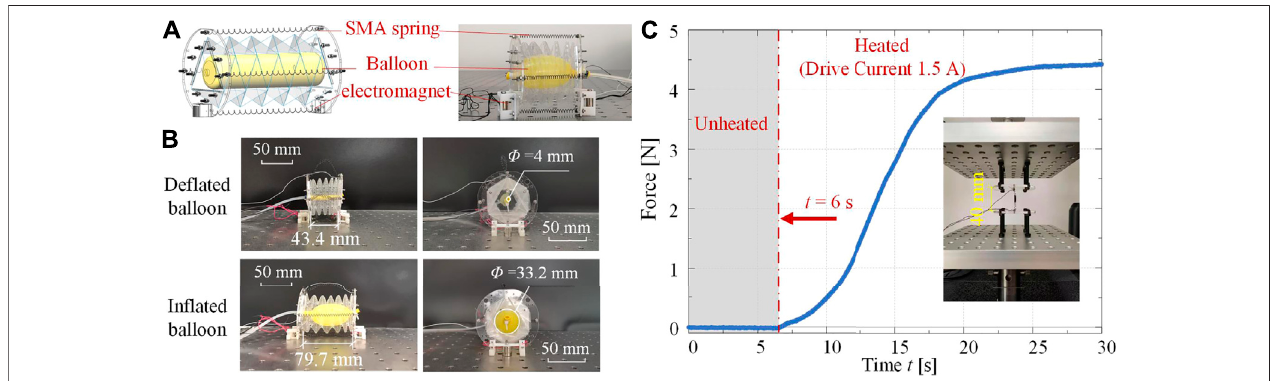
FIGURE 9 | CAD design, prototype, and actuation mechanism tests of an earthworm-like robot segment. (A) The CAD design and the photo of a robot segment. (B) Axial actuation tests of a robot segment. By in fl ating the internal balloon, the segment switches from the axially-contracted state to the axially-extended state. Both the front view and the side view of the prototype are given. (C) The experimental actuation force pro fi le of the SMA spring. The grey area represents the period when no current is applied, and the inset shows the test setup.